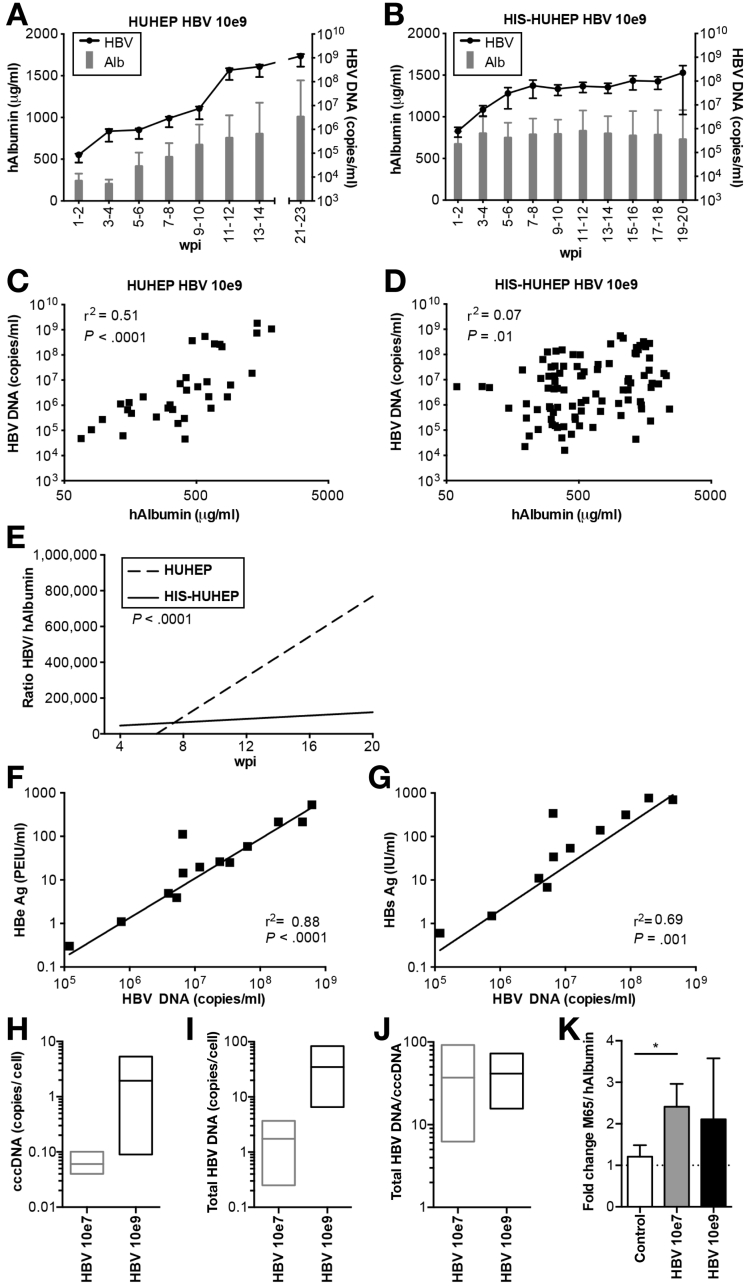
Viral progression is controlled in immunocompetent HIS-HUHEP mice. (A and B) HBV viremia (black line) and hAlbumin (grey bars) were measured in the plasma of HBV-infected HUHEP (A) and HIS-HUHEP (B) mice inoculated at 10e9. Means of HUHEP (n=4) and HIS-HUHEP (n=12) mice. (C and D) Analysis of viral load: for each plasma sample viremia was plotted against the hAlbumin concentration from HUHEP (C) (n=4) or HIS-HUHEP mice (D) (n=12). (E) Analysis of viral progression over time by linear regression analysis of the ratio of HBV DNA over hAlbumin concentration, plotted against time post infection, from HUHEP (dotted line) or HIS-HUHEP mice (filled line). The P value determines whether the slopes of each linear regression are significantly different from each other. (F and G) Plasma viral antigen loads (HBeAg and HBsAg) correlated with HBV viremia in HBV-infected HIS-HUHEP mice. (H, I, and J) Quantification of cccDNA and total HBV DNA in the liver of infected HIS-HUHEP mice. The ratio of total liver HBV DNA/cccDNA indicates the virus’ replicative activity (n=3). Bars show mininum to maximum, line at the mean. (K) Human hepatotoxicity (M65) was normalized to the degree of human liver chimerism (hAlbumin) per mouse. The fold change of M65/hAlbumin pre- and post-infection (19 ±4 wpi) are shown for each group (control n=8; HBV 10e7, n=7; HBV 10e9, n=4) Histograms show means and SEM. Statistical significance: Mann Whitney U test. Correlation analysis: r2 and P values calculated using 2-tailed Pearson's χ2 test.